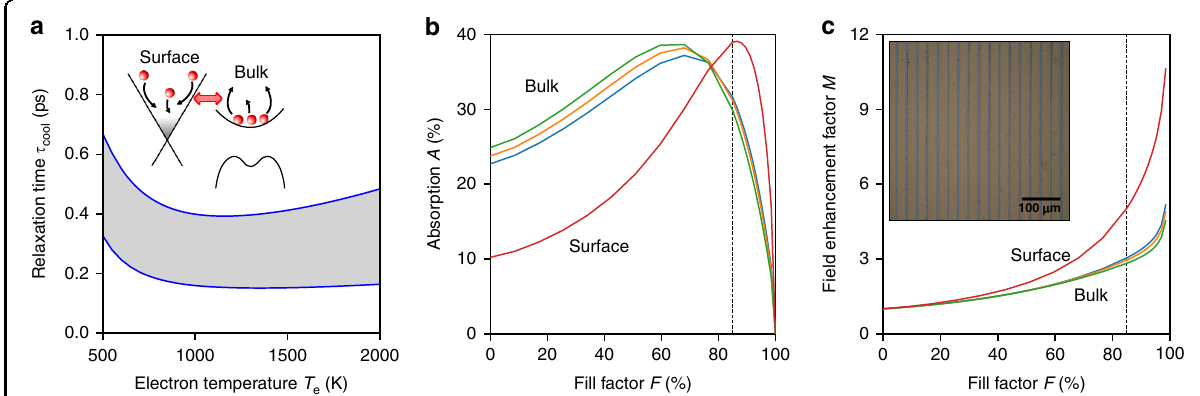
Fig. 3 Surface-bulk interplay. a Calculation results for the cooling time of surface-state carriers by dissipation of electronic heat to bulk carriers, for two sets of input parameters. The inset is a schematic of the microscopic mechanism where surface-state carriers lose energy by Coulomb interaction with bulk carriers, without surface-to-bulk charge transfer. The obtained timescale of this “ Coulomb cooling ” is in agreement with a recent study of ultrafast carrier cooling of TI surface states 8 . b , c RCWA simulation results for total THz absorption ( b ) and fi eld enhancement ( c ) for a 3D simulation using the properties of bulk carriers (blue, orange, green lines; corresponding to permittivities of 10, 180, 360, respectively) and a 2D simulation using the properties of the surface-state carriers (red lines). The grating effect is much larger for the surface-state carriers, where signi fi cant fi eld enhancement occurs. For our sample with fi ll factor F = 85% (see microscope image in the inset of panel c , where the brighter stripes are the metal grating), we fi nd fi vefold fi eld